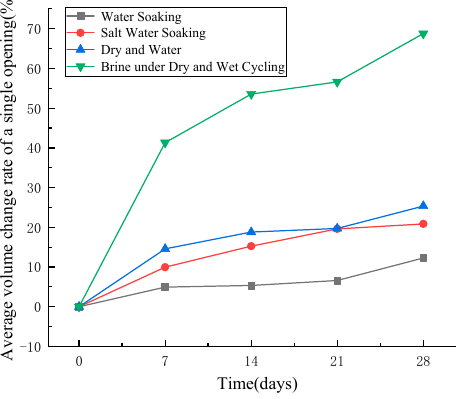
Figure 14. Volume change of single opening void.